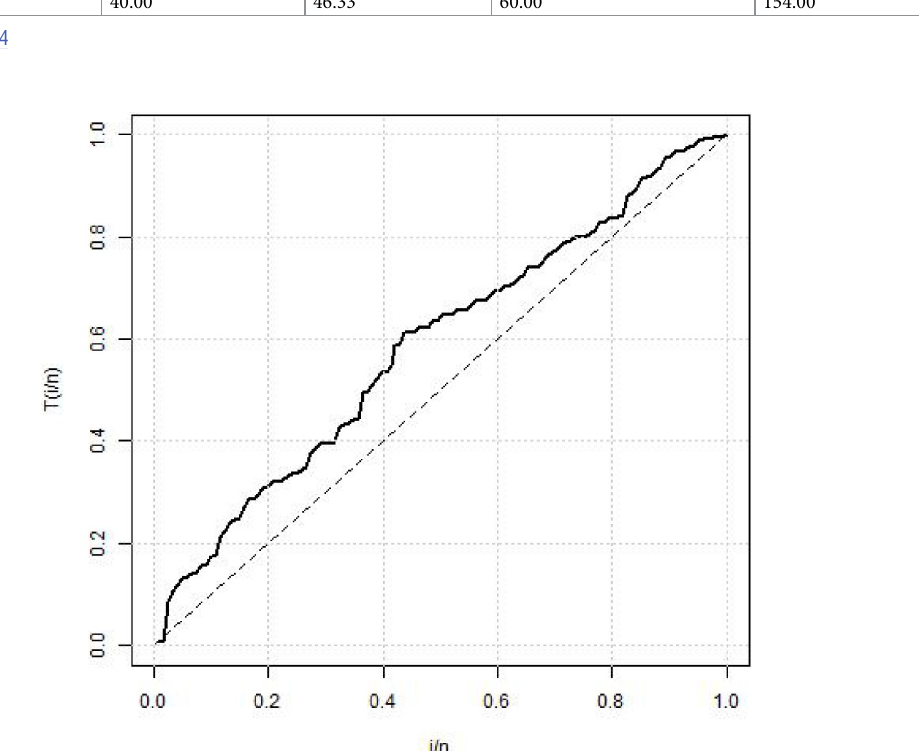
Table 4. Table displaying descriptive analysis of survival time of breast cancer patients. Minimum